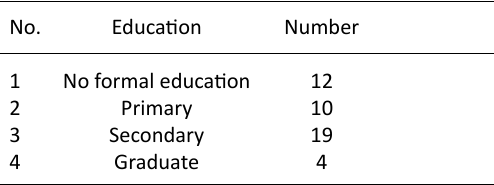
Table 3. Distribution of food handlers on the basis of literacy level